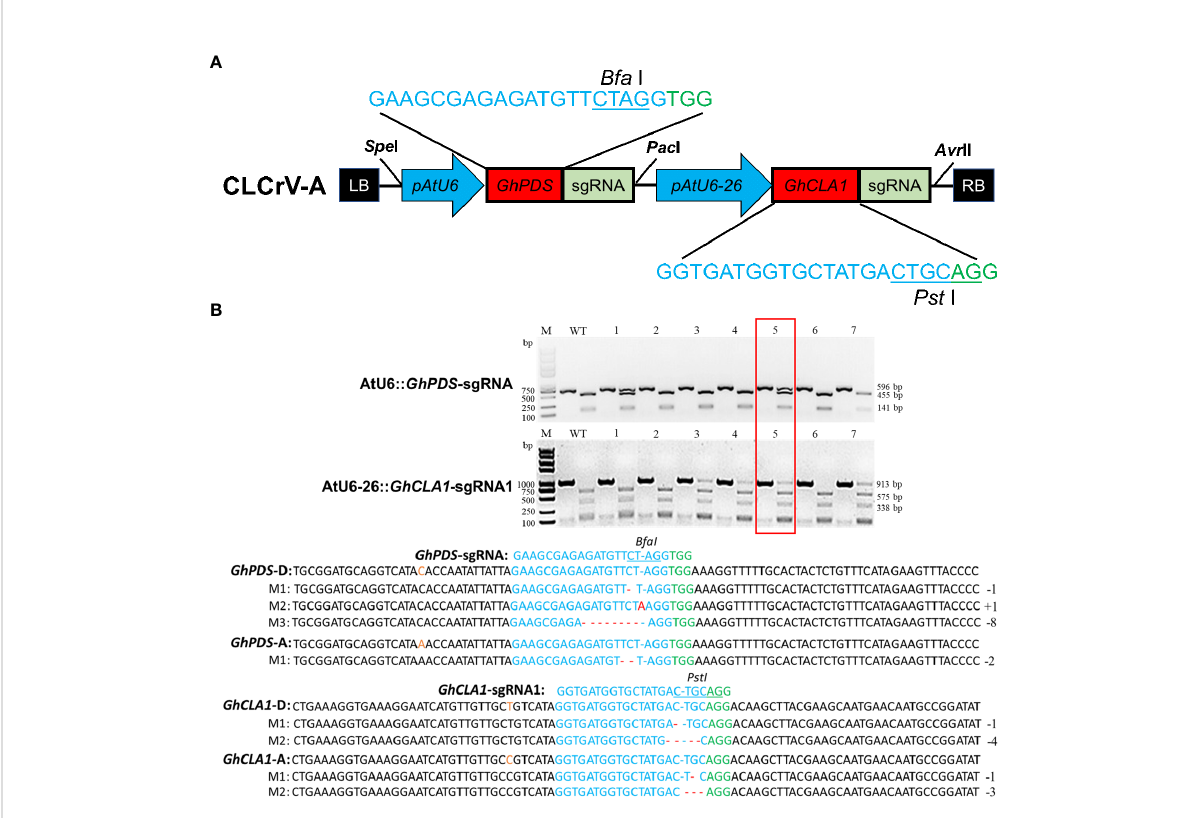
FIGURE 4 CLCrV-mediated simultaneous editing of GhCLA1 and GhPDS genes in cotton. (A) CLCrV-mediated design strategy for simultaneous editing of GhCLA1 and GhPDS . (B) Detection of GhPDS -sgRNA and GhCLA1 -sgRNA1 targeted double mutations. Wild-type served as a control, and 1-7 were plant numbers. The gel image shows PCR products of the GhCLA1 gene and GhPDS gene, and digested PCR products with Pst I and Bfa I. The undigested PCR products lacking the Pst I and Bfa I site (due to the presence of a mutation) that were subsequently puri fi ed, cloned, and analyzed by sequencing. The red box indicates the double mutation of GhCLA1 and GhPDS . The green color indicates the PAM sequence. The restriction site on the target sequence is underlined in blue. M indicates the mutation sequence. Insertions are denoted with red capital letters. Deletions are shown as red